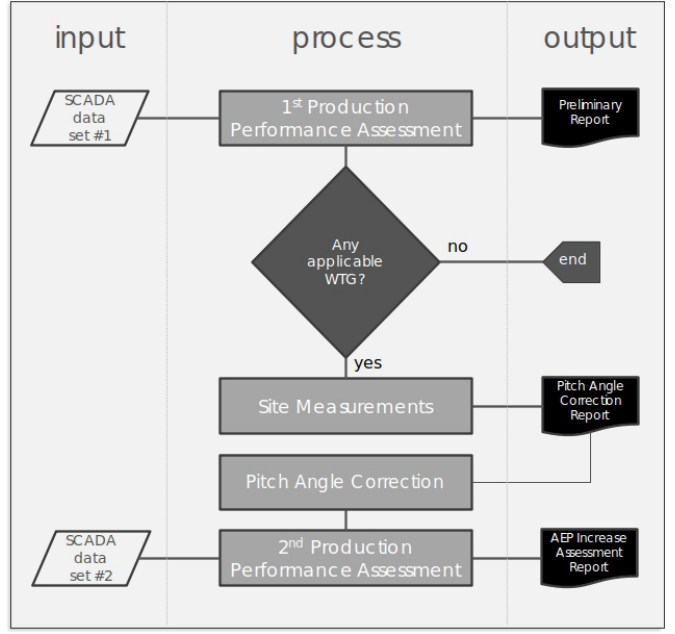
Figure 8. Pitch angle detection and correction